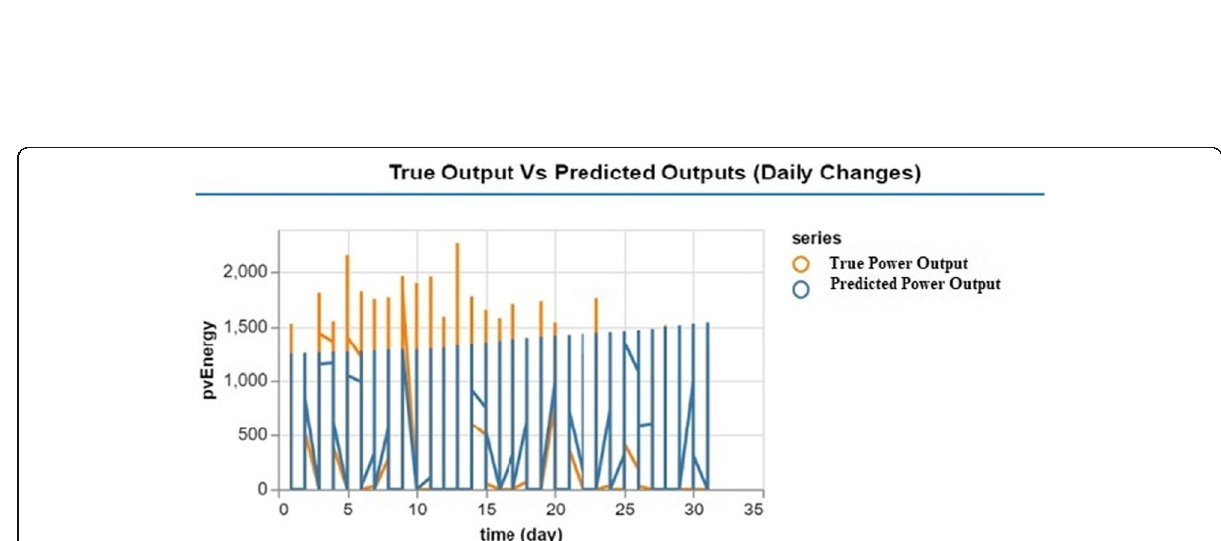
Fig. 8 Forecast of daily solar power